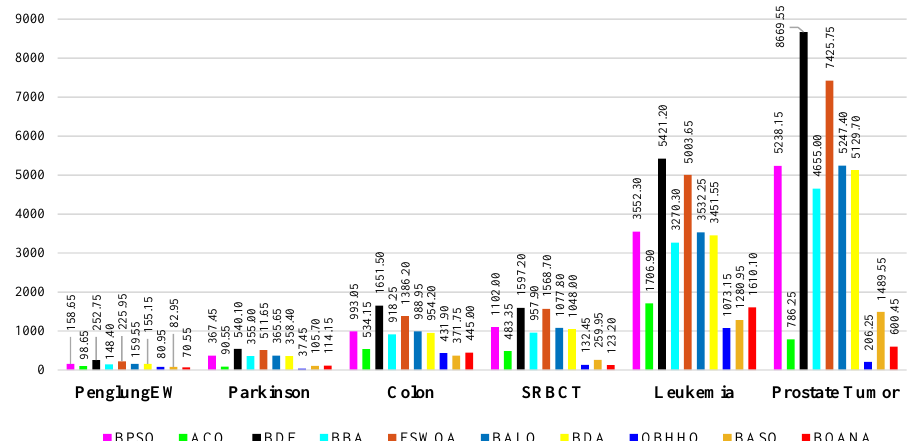
Figure 7. The average number of features selected by BQANA and comparative algorithms on medium and large datasets.